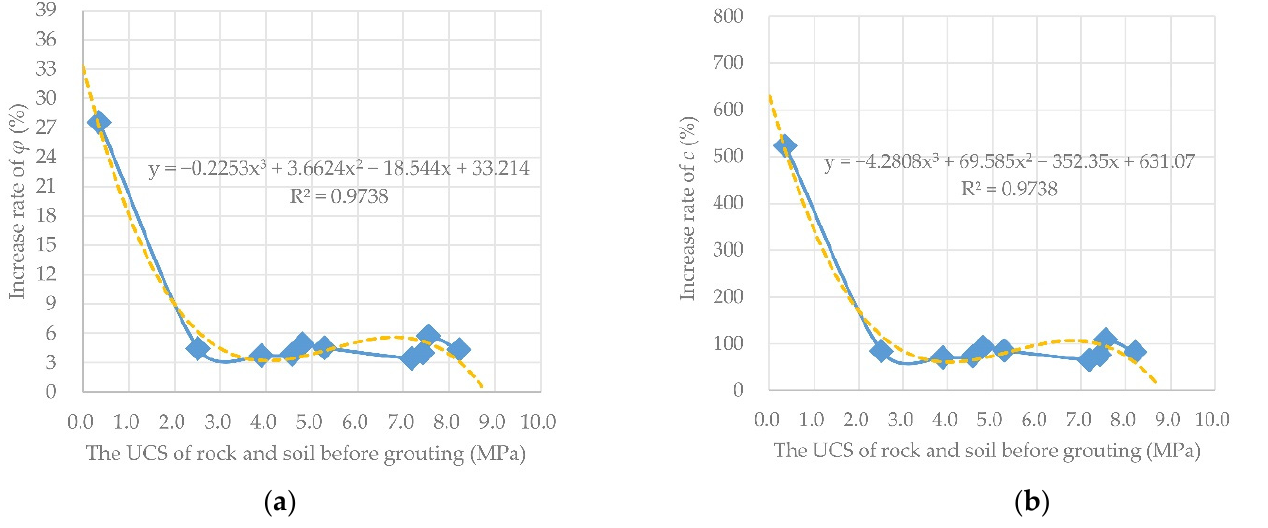
Figure 8. Relationship between the UCS of rock and soil before grouting and the shear strength parameter increase rate of rock and soil after grouting when water–cement ratio η = 0.75: ( a ) Relation between the increase rate of ϕ and the UCS of rock and soil before grouting; ( b ) relation between the increase rate of c and the UCS of rock and soil before grouting.